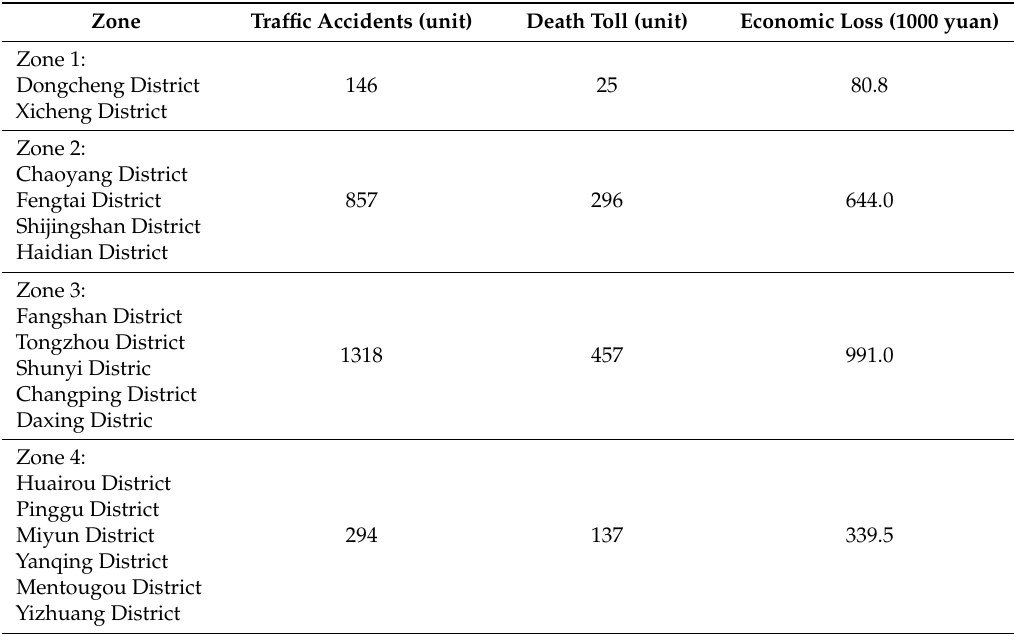
Table 1. Differences of traffic accident in urban functional